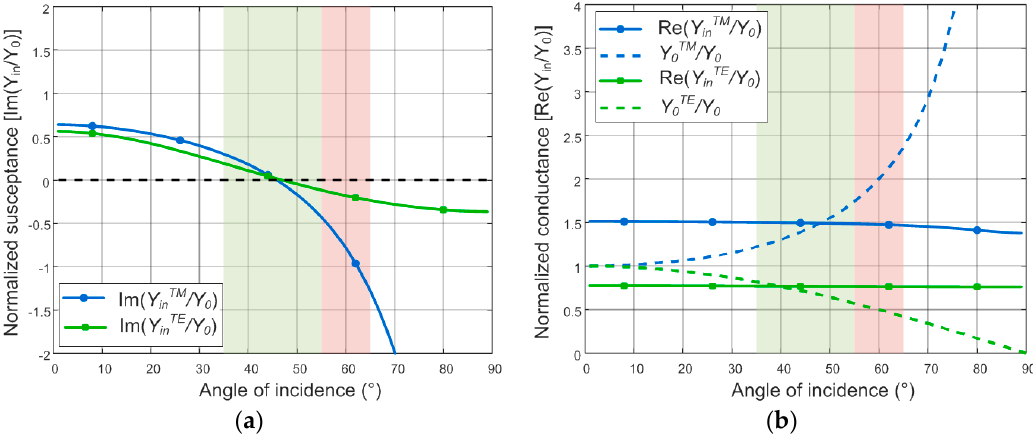
Figure 4. Imaginary ( a ) and real ( b ) part of Y in / Y 0 with respect to the angle of incidence at 2.15 GHz for sector A and both polarizations.